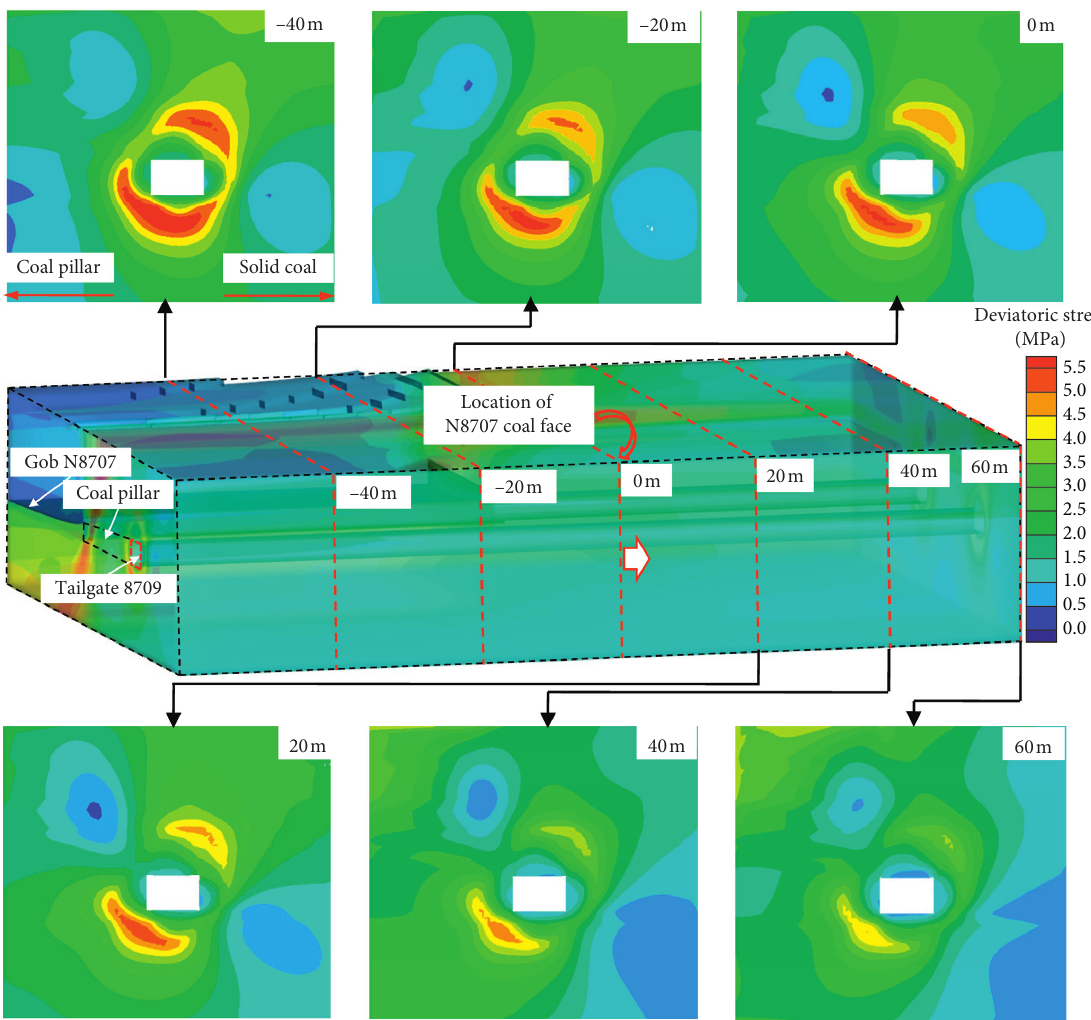
Figure 6: Nephograms of deviatoric stress of Tailgate 8709 in the mining process of the N8707 coal face in No. 11 coal